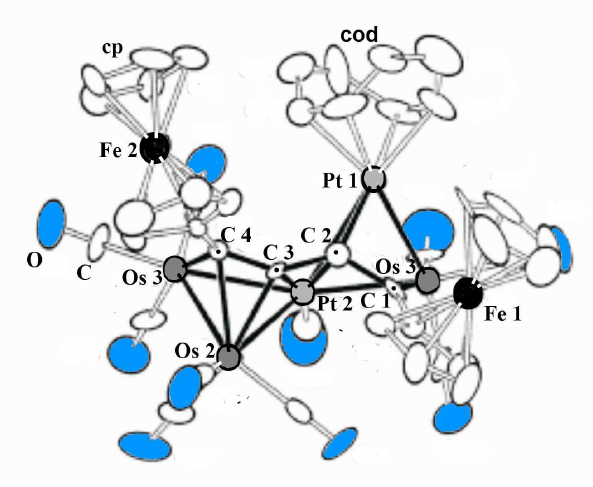
Os (CO) (µ -cpbcp)Fe 2 3 10 4